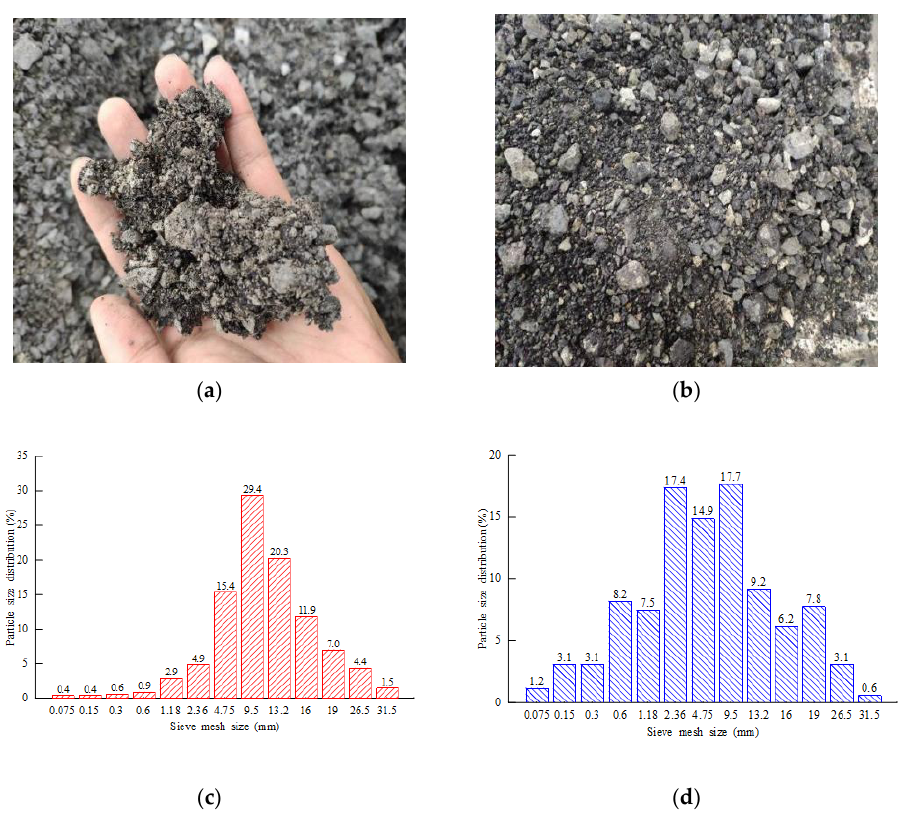
Figure 1. Reclaimed asphalt mixture: ( a ) coarse aggregate; ( b ) fine aggregate; ( c ) untreated. ( d ) Ex- tracted RAP particle-size distribution